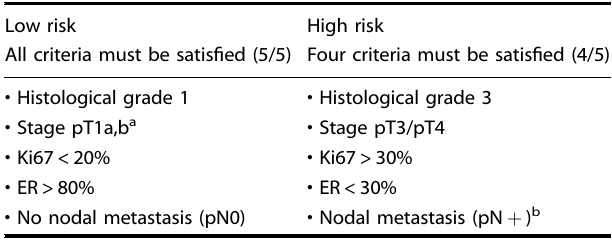
Table 1. Italian criteria for multigenic prognostic test in breast cancer. Low risk High